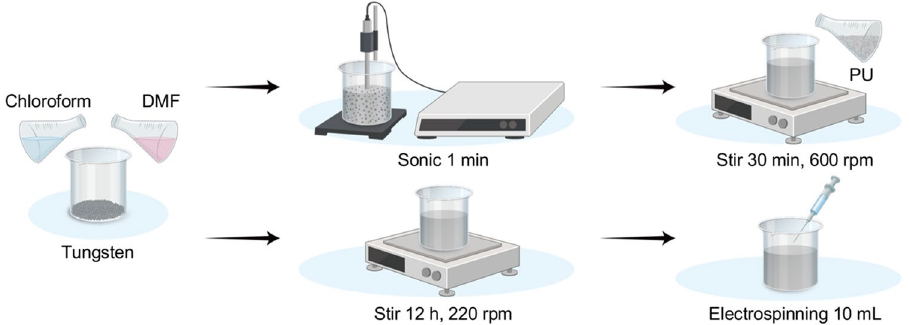
Figure 3. Preparation of the spinning solution used for the production of thin-film shielding paper.